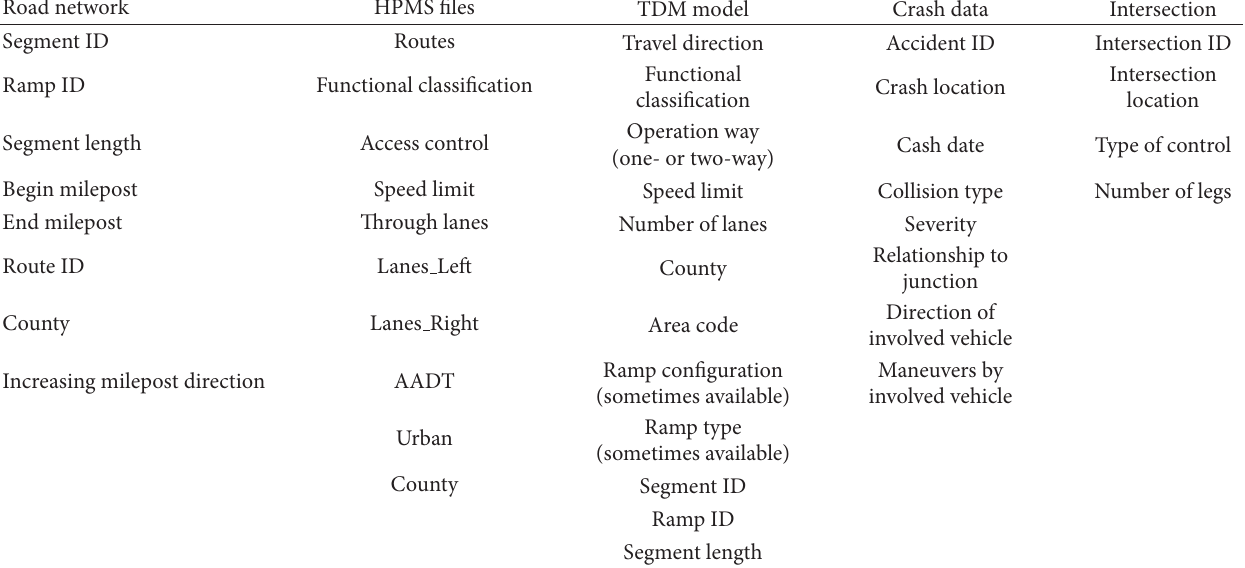
Table 1: Source files and their data elements to build a safety